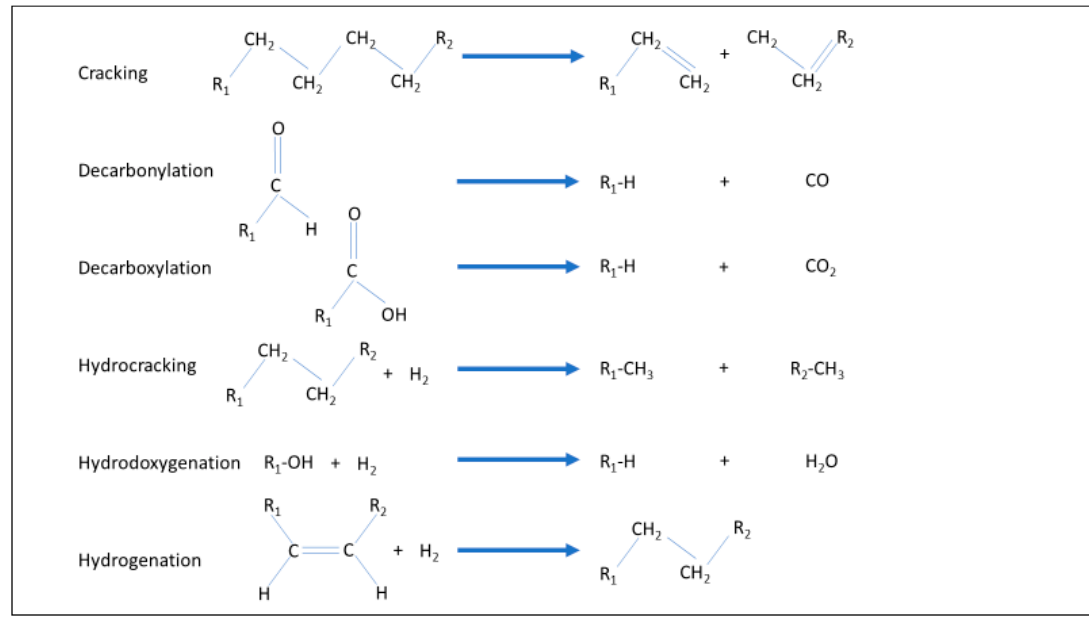
Figure 1. Reactions of hydrotreating.